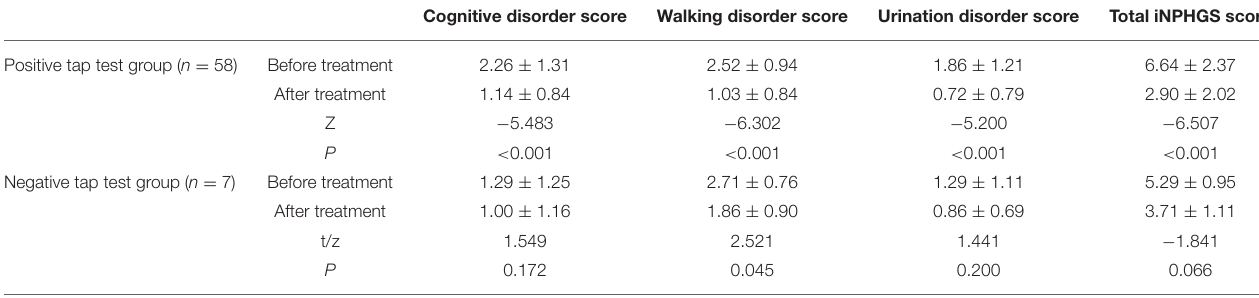
TABLE 2 | Comparisons of symptoms between the positive and negative tap test groups using Japanese iNPH grading scale (iNPHGS).